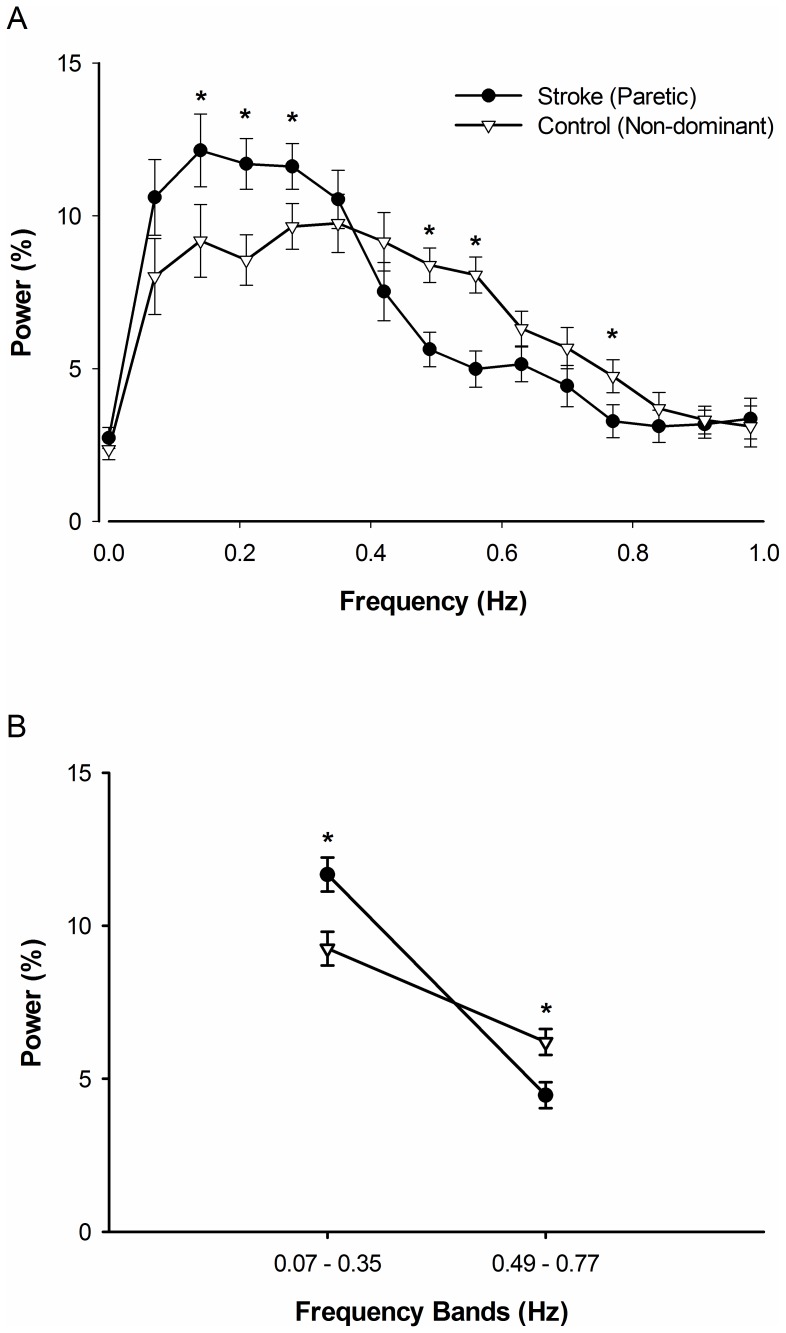
The modulation of power below 1 Hz for stroke and control groups.
(A) The stroke group demonstrated significantly greater relative power at 0.14, 0.21 and 0.28 Hz compared with the control group (p<0.05). However, this relationship reversed at higher frequencies. Specifically, the stroke group had significantly reduced power at 0.49 Hz, 0.56, and 0.77 Hz compared with the control group (p<0.05). (B) The average power in frequency bands 0.07–0.35 Hz and 0.49–0.77 Hz for stroke and control participants. The stroke group shows greater power within 0.07–0.35 Hz (p<0.05) and reduced power within 0.49–0.77 Hz (p<0.05).